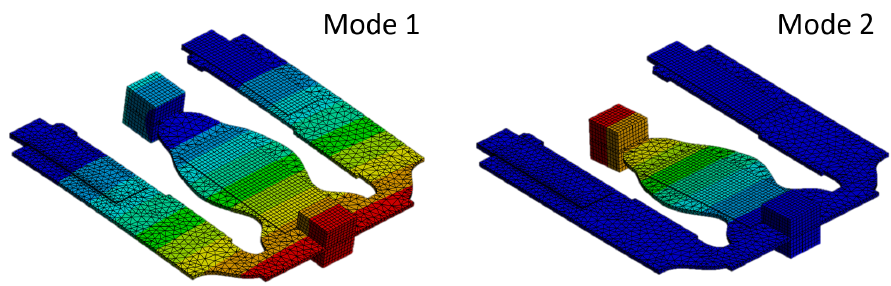
Figure 7. Mode shapes of the first two resonant modes of the optimal structure after the conversion to a manufacturable design value at f 1 = 74.573 Hz and f 2 = 79.054 Hz.